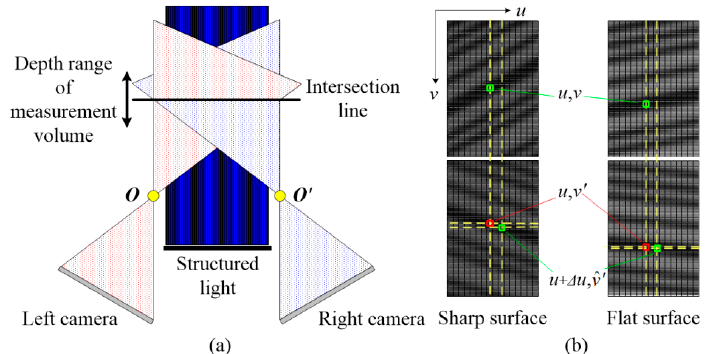
Figure 5. Matching error against non-coplanar viewing planes. ( a ) Misalignment of two viewing planes; and ( b ) schematic drawing of the matching error.